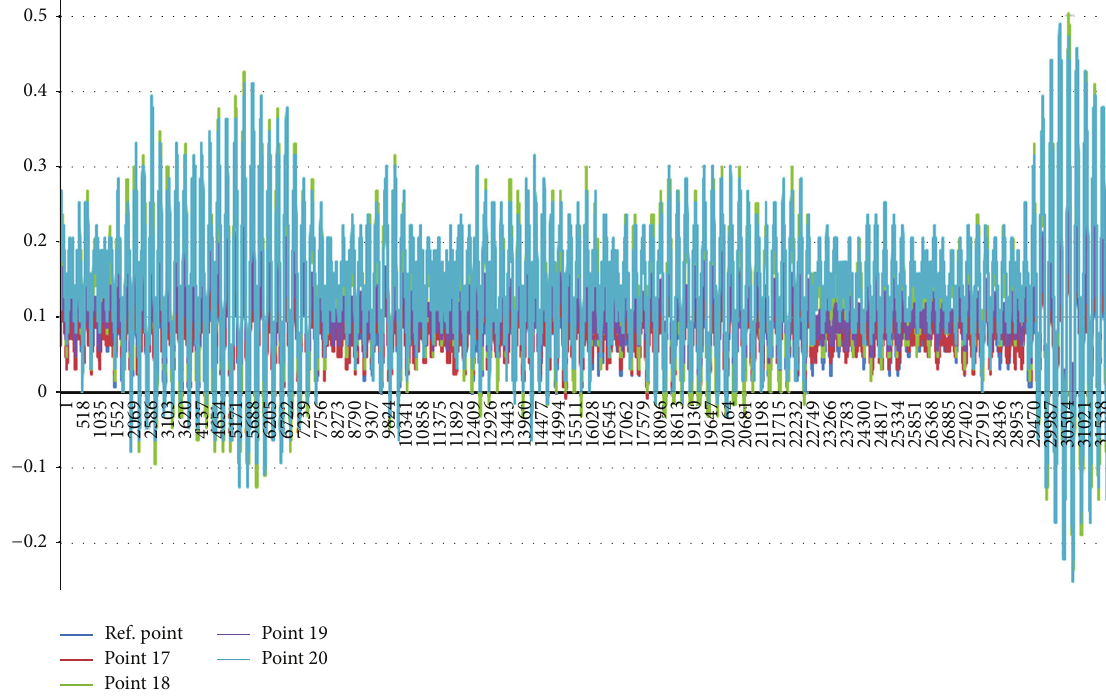
Figure 21: Comparison of transversal channels.